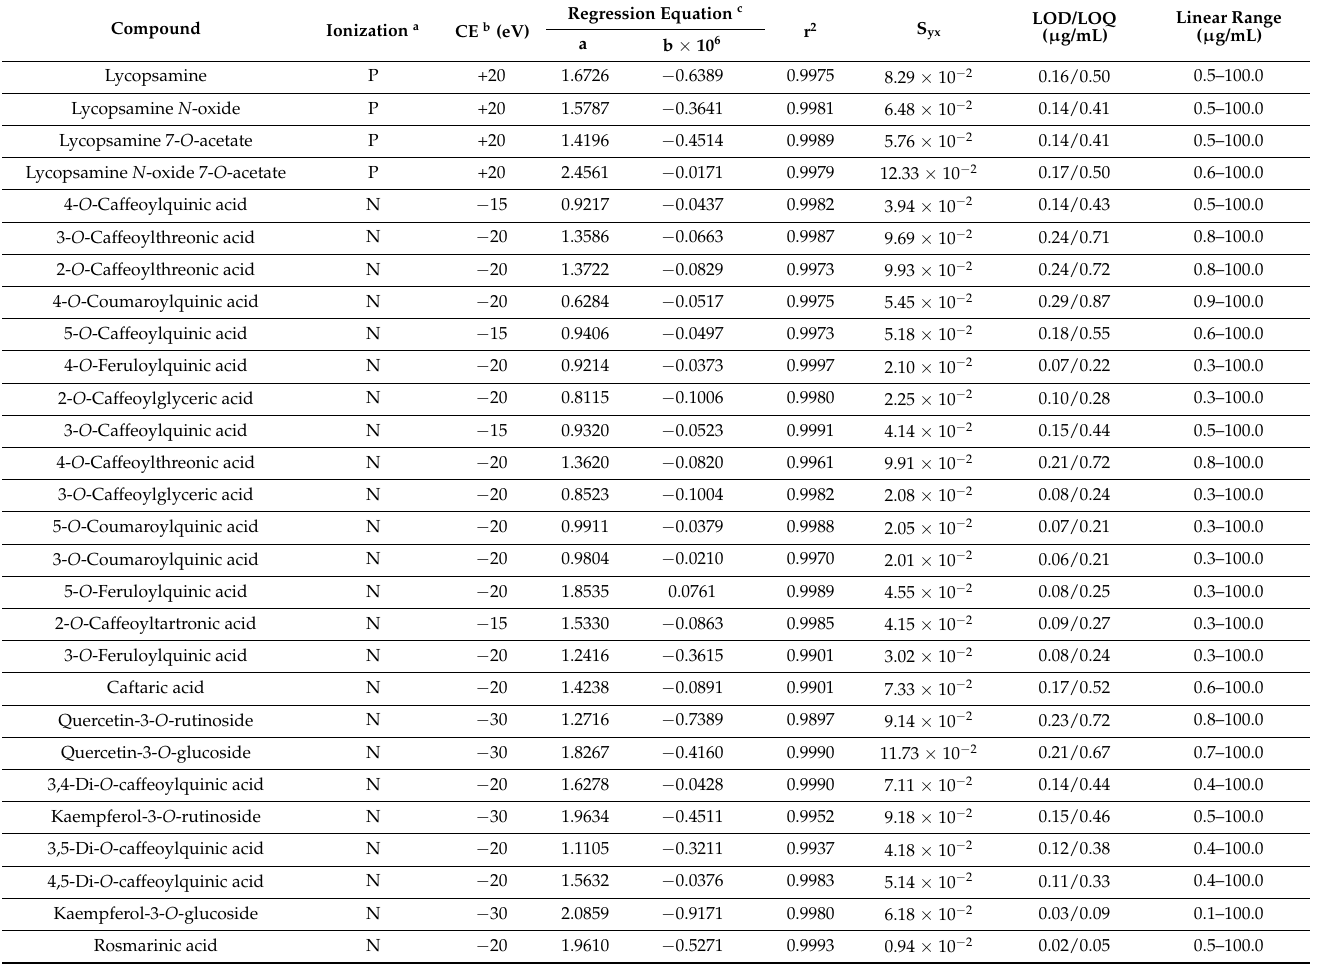
Table 1. Regression equations, correlation coefficients (r 2 ), standard deviation (S YX ), limits of detec- tion (LOD), limits of quantification (LOQ), and linear ranges for 28 reference